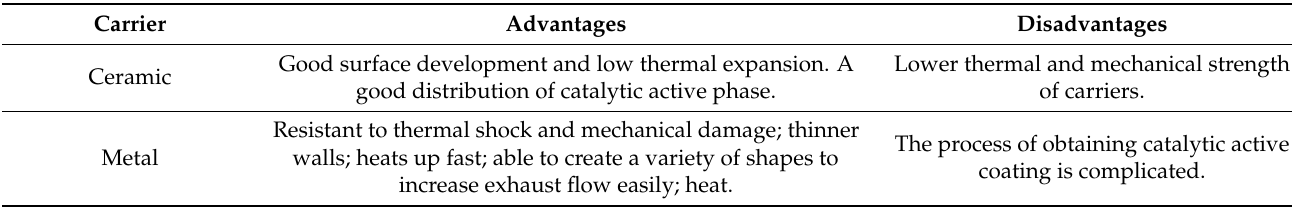
Figure 4. Structural differences between the metallic and ceramic monolithic substrate [33]. Table 1. Advantages and disadvantages of ceramic and metal carriers [26].